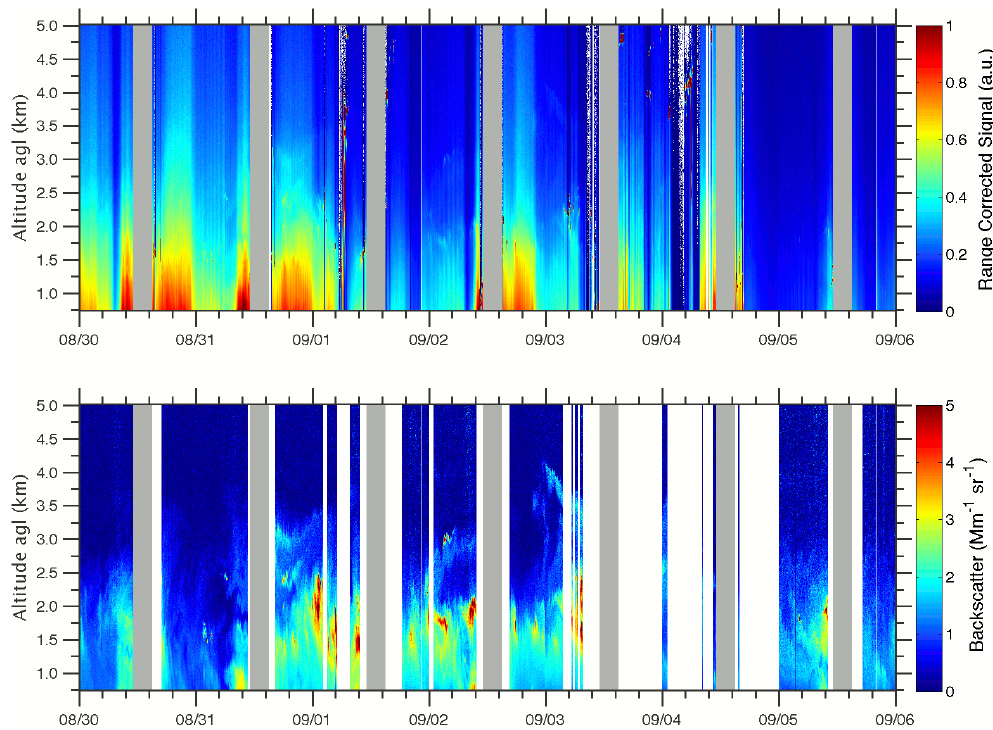
Figure 10. Range and background corrected signal (top, a . u.) and aerosol backscatter coefficient (bottom, Mm − 1 sr − 1 ) obtained from the elastic channels are shown below 5km from 30 August to 6 September 2011. Inversion assumed a particle lidar ratio of 55sr − 1 . Gray and white regions correspond to local solar noon and clouds, respectively.